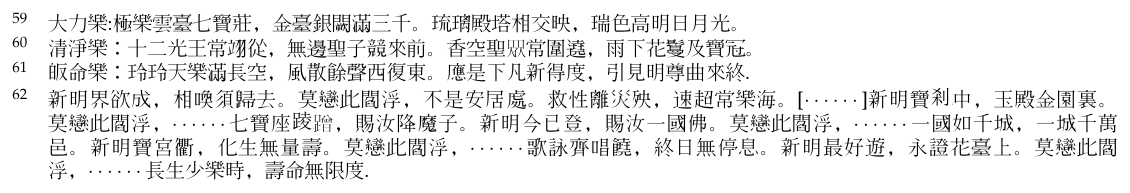
Figure 10. Four Great Venerable Buddhas (Gulácsi 2016, Figure 6/17 [p. 368]). 3.2.14. Rest ( xieshi 歇時 ), Performing Worshipping ( zuo xinli 做信禮 ) (cc.